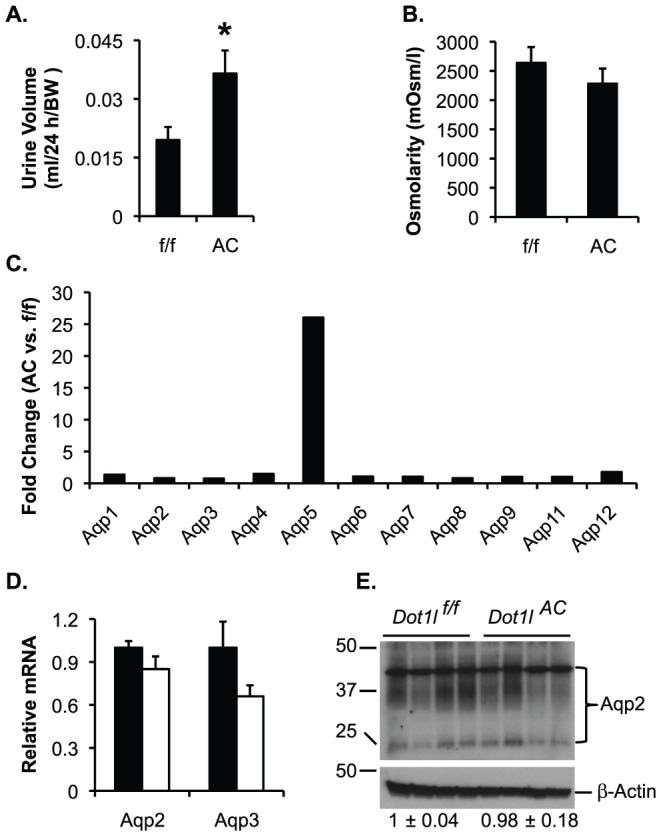

Dot1l
AC mice displayed polyuria without impaired Aqp2 expression.(A–B). Dot1lf/f and Dot1lAC mice deprived of water for 24 h (n = 14 mice/group) were subjected to 24-h urine analyses as indicated. For additional measurements, see Figure S1. *P<0.05 vs. Dot1lf/f. (C) Dot1lAC vs. Dot1lf/f mice (n = 4 mice/group, see Materials and Methods) have only subtle changes in the expression of all known Aqps as indicated except for Aqp5. Shown are the fold changes revealed by cDNA array anlalysis. (D) Real-time RT-qPCR for expression of Aqp2 and AQP3 in kidney of mice fed the normal Na+ pellet diet, with β-actin as internal control. n = 6 mice/group. (D) IB for Aqp2 expression, with β-actin as internal control. n = 4 mice/group.